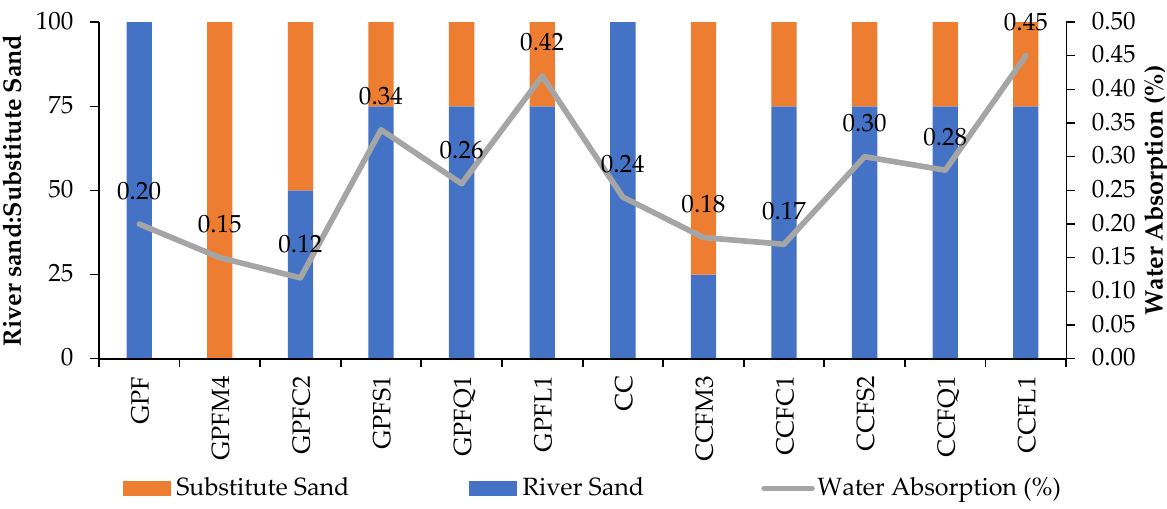
Figure 9. Percentage of water absorption in GPC and CC.